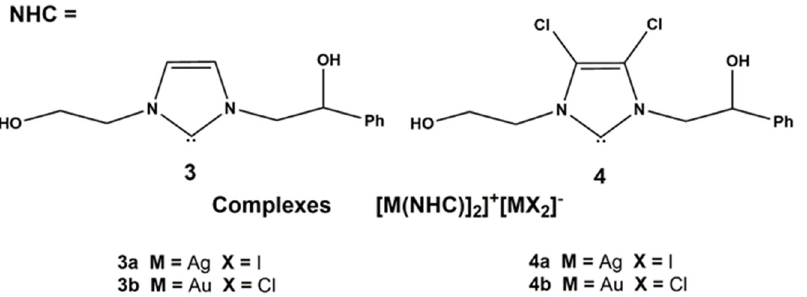
Figure 1. Recently reported NHC silver(I) and gold(I) complexes.